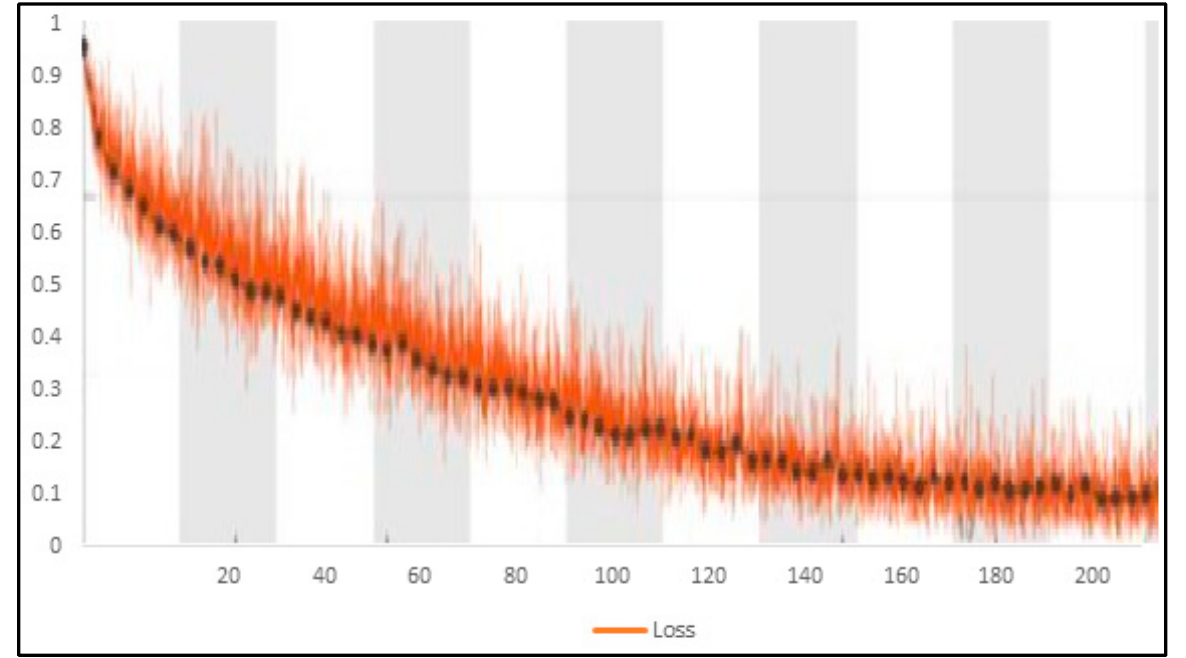
Figure 9. Training loss for the proposed improved BoxENet model.